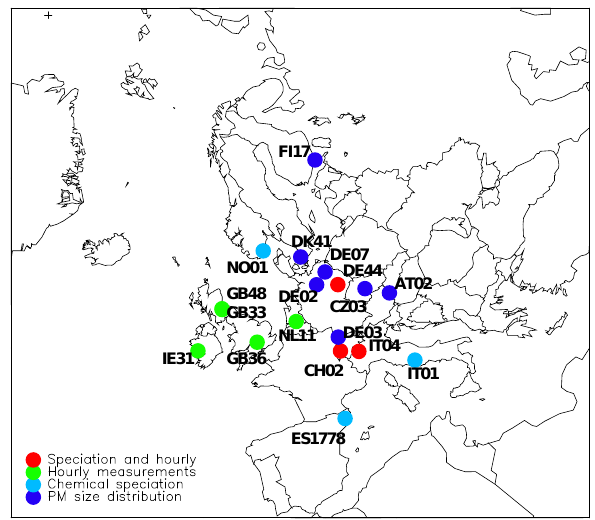
Fig. 1. Sites that took part in the EMEP intensive measurement pe- riods in June 2006 and/or January